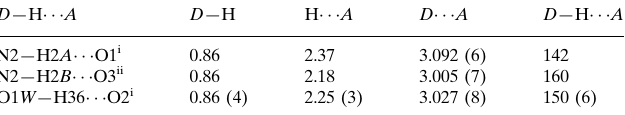
Hydrogen-bond geometry (A˚ , (cid:3)